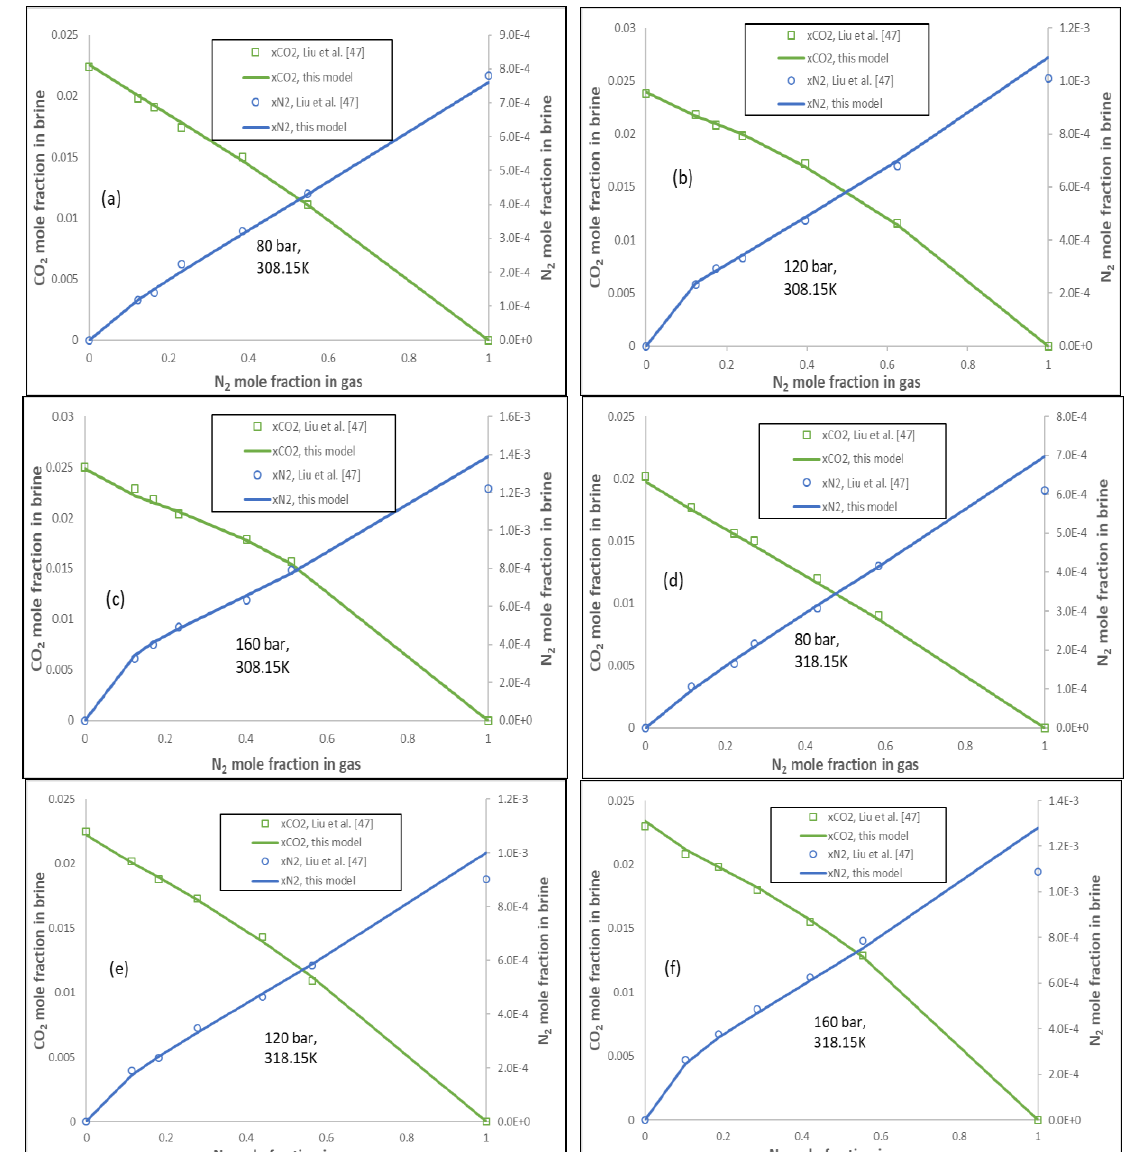
Figure 4. CO 2 -N 2 -H 2 O equilibria (i.e., CO 2 and N 2 mole fractions in brine varying with N 2 mole fractions in gas) obtained from experimental work (Liu et al. [47], dots) and the calculated results (lines) by the model in this work at various values of temperature and pressure. ( a ) at P=80 bar and T=308.15 K; ( b ) at P=120 bar and 308.15 K; ( c ) at P=160 bar and T=308.15 K; ( d ) at P=80 bar and T=318.15 K; ( e ) at P=120 bar and T=318.15 K; ( f ) P=160 bar and T=318.15 K.